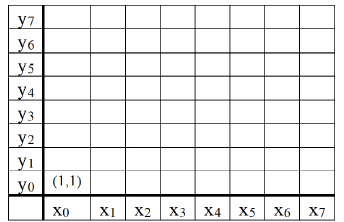
Figure 12. Sphere surface deployment on two dimensions.